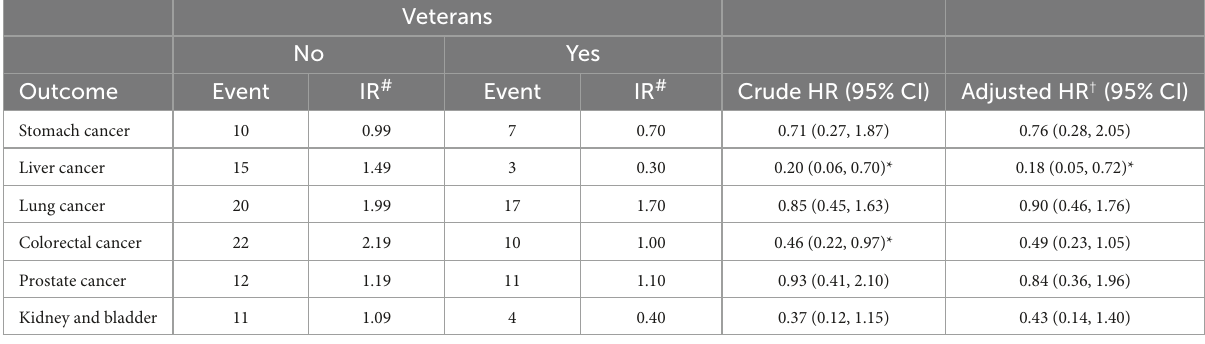
TABLE 4 Comparison of incidence and hazard ratio of cancer type on the propensity score matched cohorts. Veterans